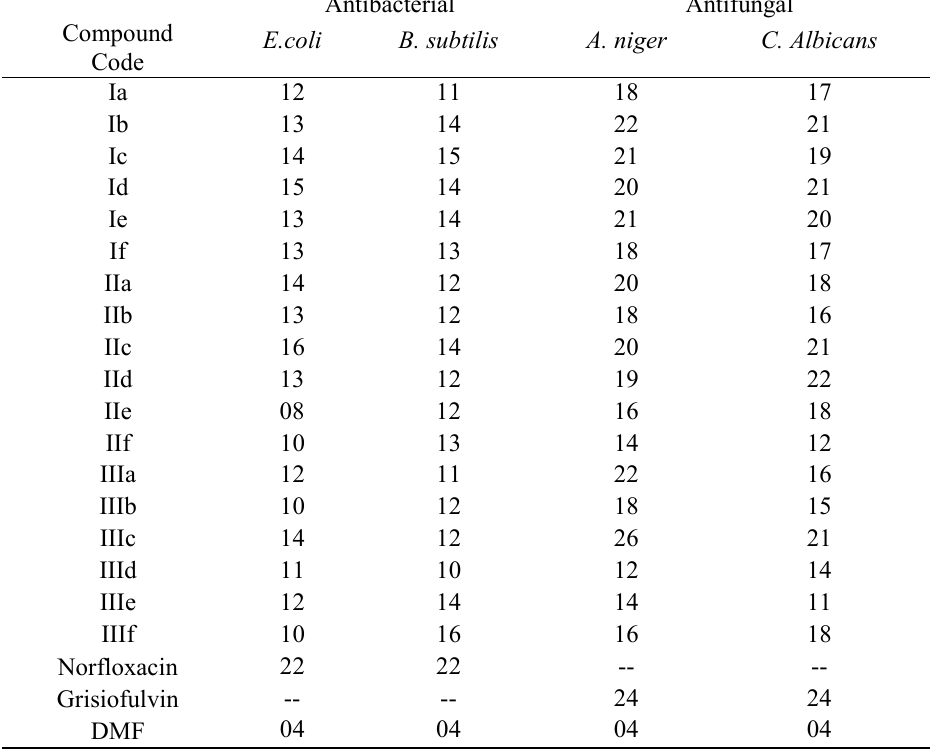
Table 4. Anti-microbial activities of synthesized compounds I(a-f), II(a-f), and III(a-f).